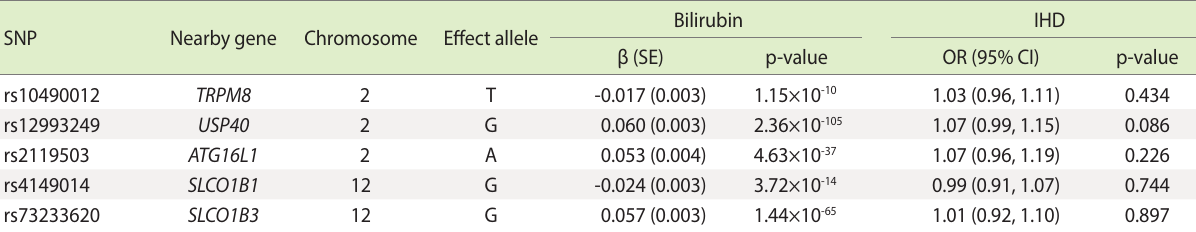
Figure 1. Overview of the study design